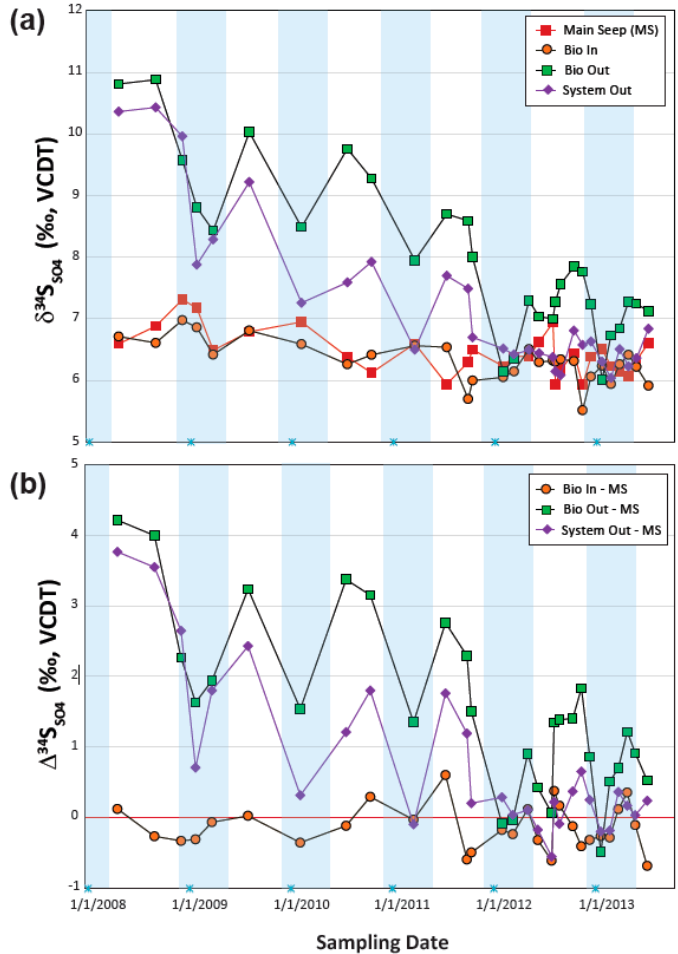
Figure 10. Temporal trends for ( a ) the sulfur isotope values of dissolved sulfate ( δ 34 S SO4 ) in water samples collected from the Main Seep (MS), Bioreactor Inlet (Bio In), Bioreactor Outlet (Bio Out), and the System Outlet (System Out); and the ( b ) difference between the sulfur isotopic values of the Bio In, Bio Out, and System Out effluent dissolved sulfate and MS influent dissolved sulfate ( Δ 34 S SO4 ). Within the Tab-Simco PBS, the widest range of δ 34 S ( δ 34 S = − 2.3